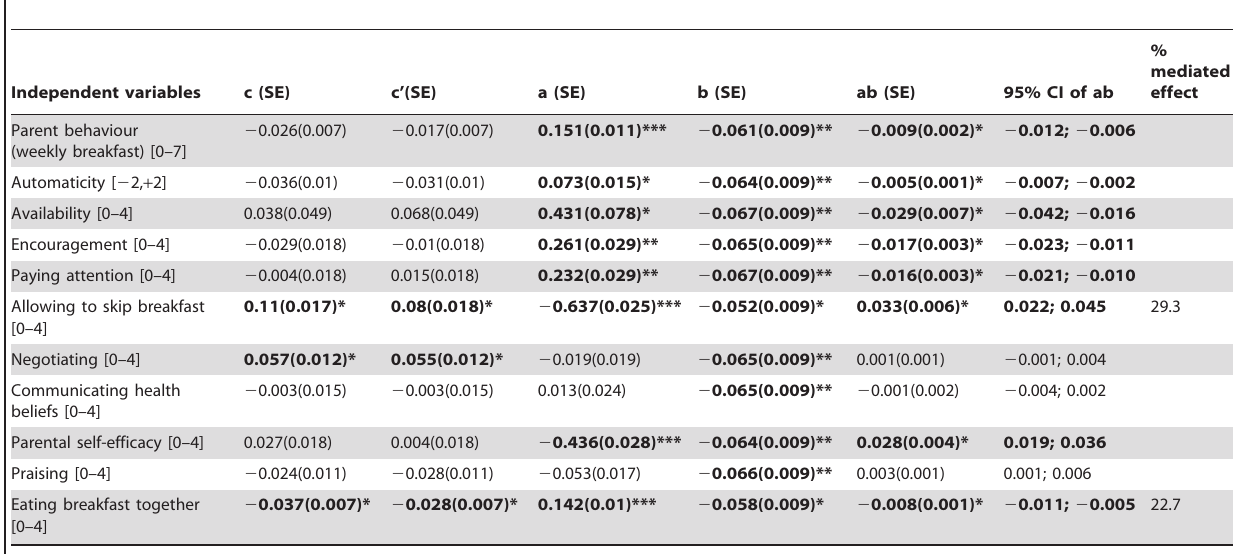
Table 3. Associations between independent (family-related factors) and dependent variable (children’s BMI-z-score), action and conceptual theory test, and mediation effects of children’s breakfast behaviour (times per week) on the association between independent and dependent